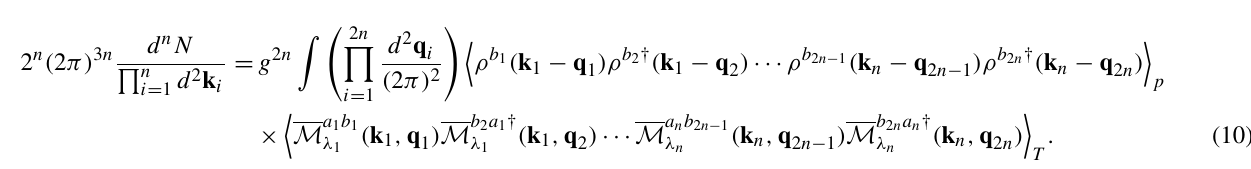
Using Eq. (1) and dropping the dependence on η due to the eikonal approximation, we can write this expression as (see Fig.